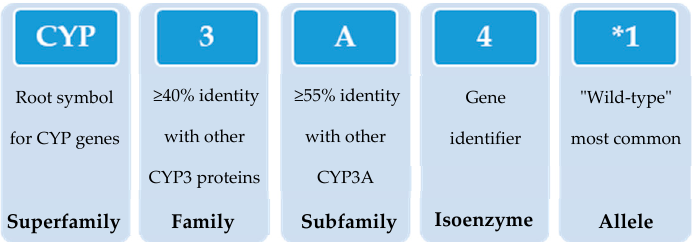
Figure 3. Schematic representation of the nomenclature system of CYP genes (example of CYP3A4*1).